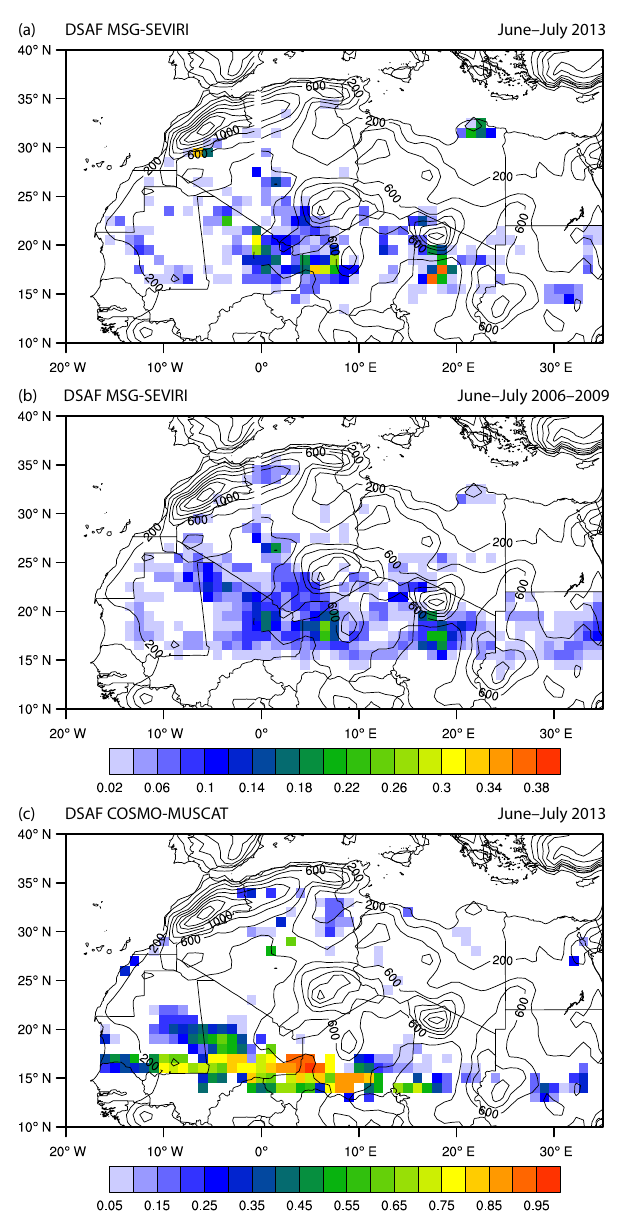
Figure 1. Occurrence frequency of dust source activation (frac- tion of days with dust occurrence) for the 2-month period June and July for 2013 (a) and the 4-year period 2006–2009 (b) . (c) Occur- rence frequency of dust source activation (DSAF) obtained from COSMO-MUSCAT simulations. For each day, grid cells repre- senting dust emission fluxes exceeding 1 × 10 − 4 kgm 2 day − 1 were counted as dust emission event. Topography (m) is given by the black solid lines at 200m